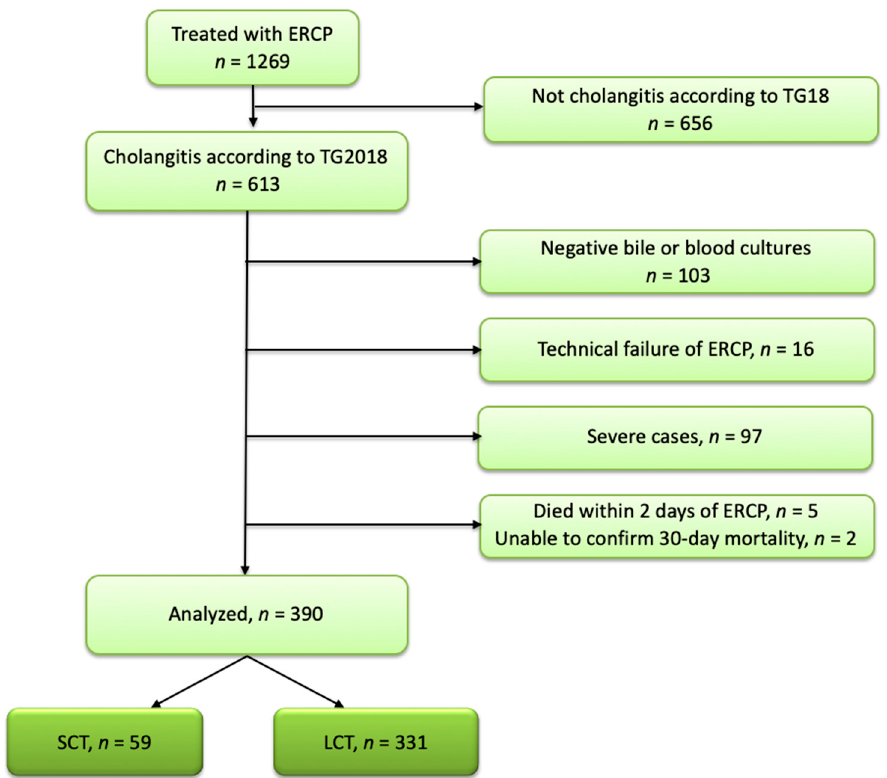
Figure 1. Study population. SCT: short course antibiotic therapy; LCT: long course antibiotic therapy; ERCP: endoscopic retrograde cholangiopancreatography; TG18: Tokyo Guidelines 2018.